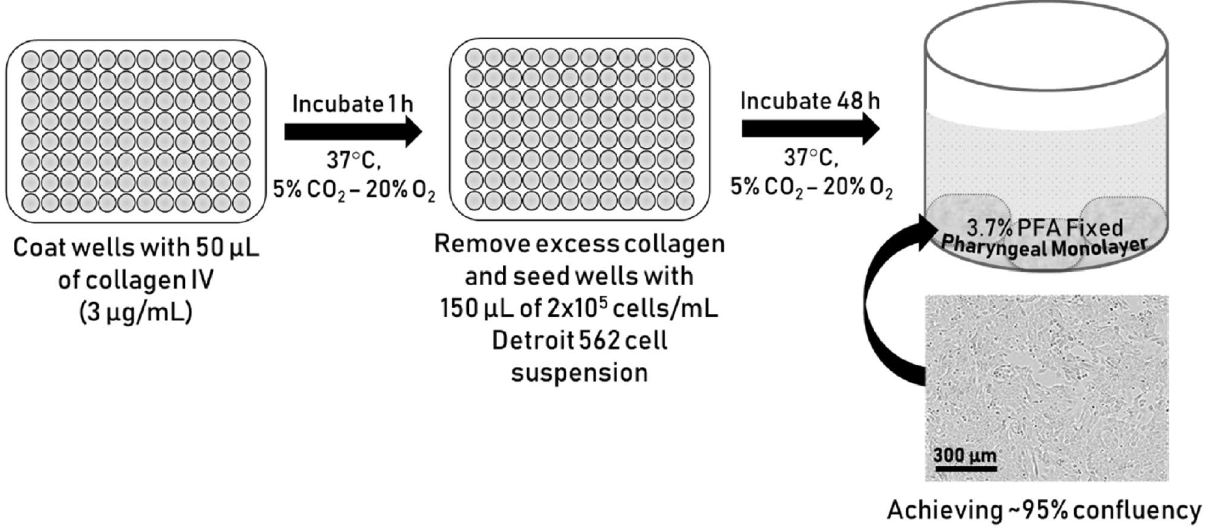
Figure 1. Schematic outlining the process of Detroit 562 pharyngeal cell monolayer formation. Schematic shows collagen coating, seeding with Detroit 562 pharyngeal cells, and finally an example well containing